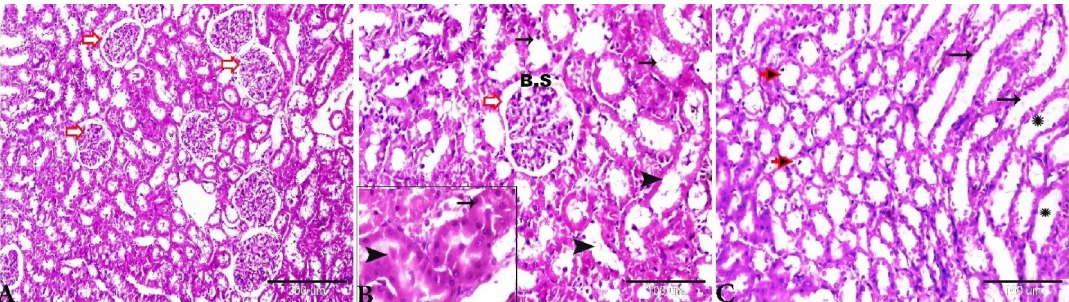
Figure 2. Photomicrograph of the rat kidneys of Group I showed normal histology architectures. ( A , B ) Renal cortex contains normal glomerulus (red arrows) and Bowman’s space (BS). Proximal convoluted tubules (B, thin arrows) and distal convoluted tubules (B, thick arrowheads), magnified in the selected square. ( C ) Normal renal medulla, thick ascending, Henle’s loop (black thin arrows), thick descending, Henle’s loop (stars), thin segment, Henle’s loop (red arrows). H&E stain, the bar size was indicated under